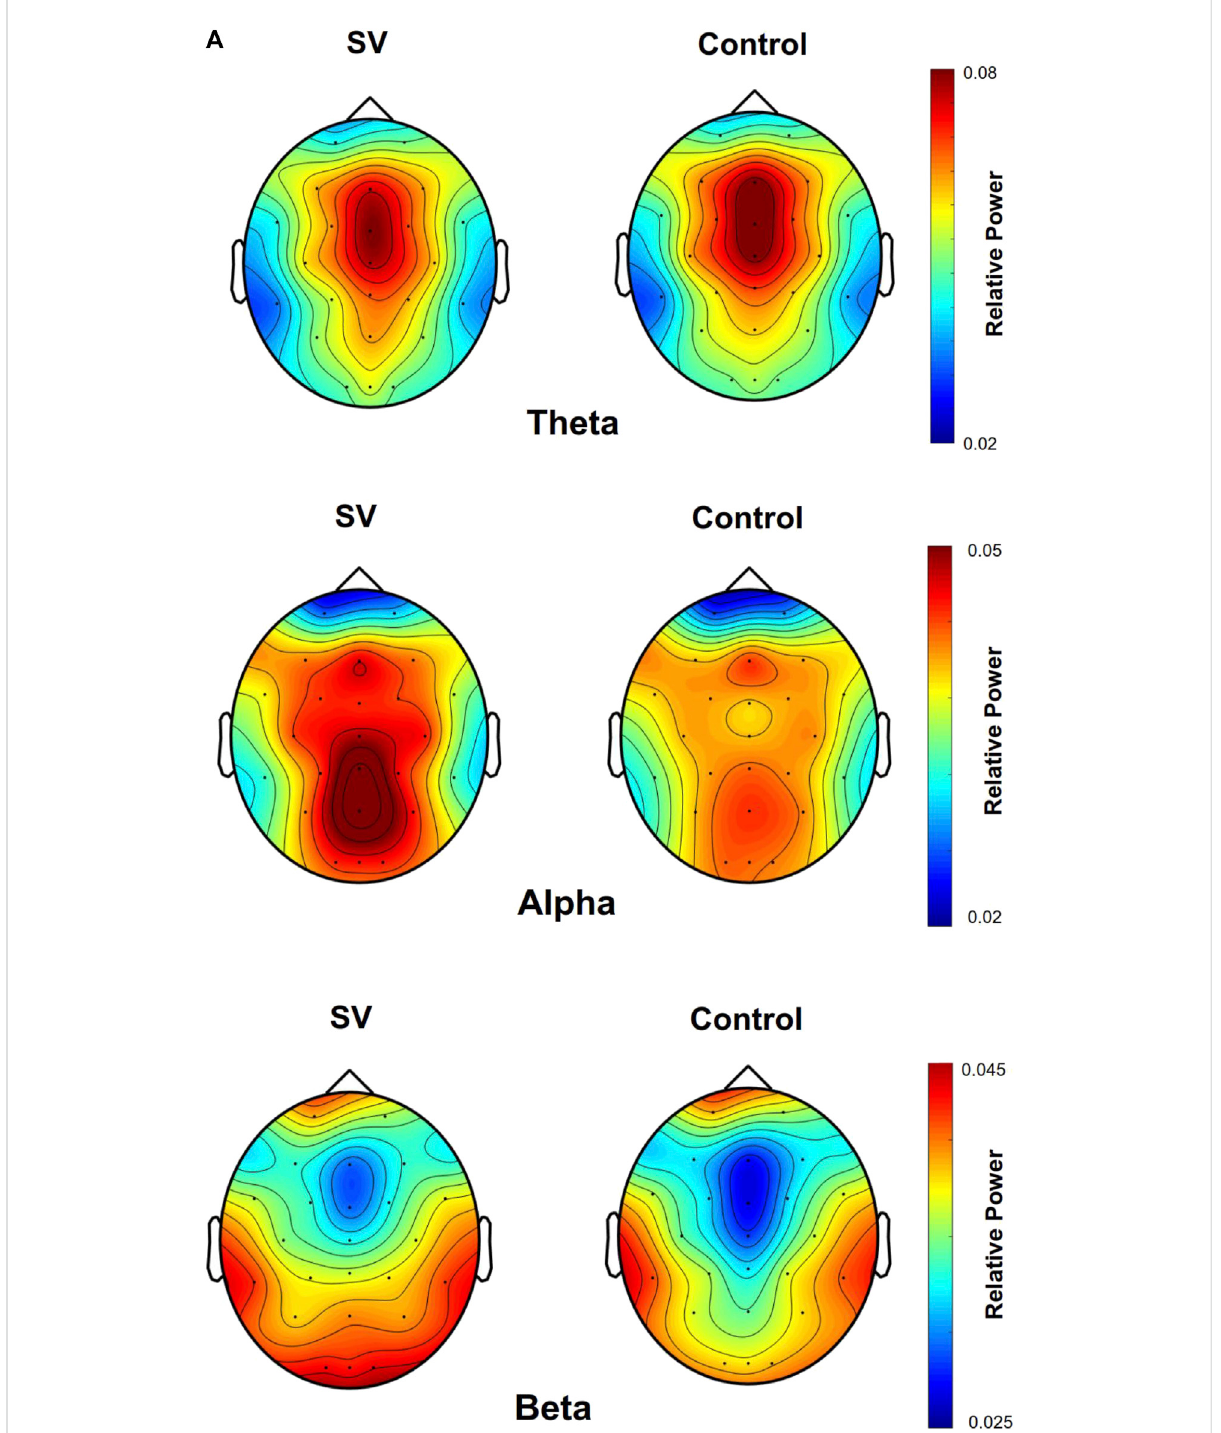
FIGURE 2A The pooled topological spectral mapping of scalp EEG at the theta (4 – 7 Hz), alpha (8 – 12 Hz), and beta bands (13 – 35 Hz) in the stroboscopic vision (SV) and control conditions. Oscillatory waves in the theta and alpha bands are most evident in the mid-frontal and parietal-occipital areas, respectively. Beta oscillation is most evident in the mid-frontal and bilateral temporal areas in the control condition. Relative powers of theta, alpha, and beta bands are selectively tuned to stroboscopic